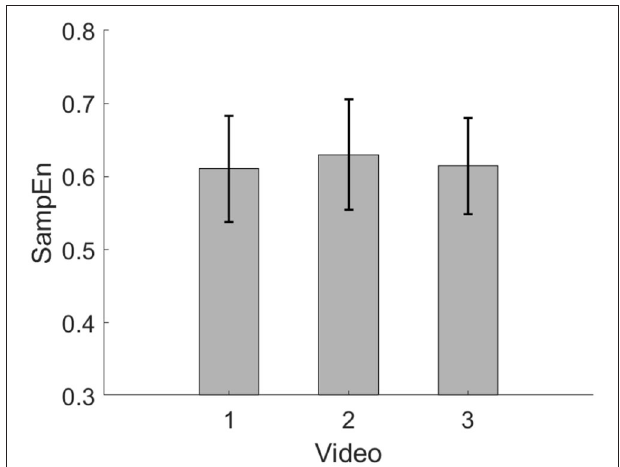
FIGURE 8 | Average SampEn of three videos in session 2.